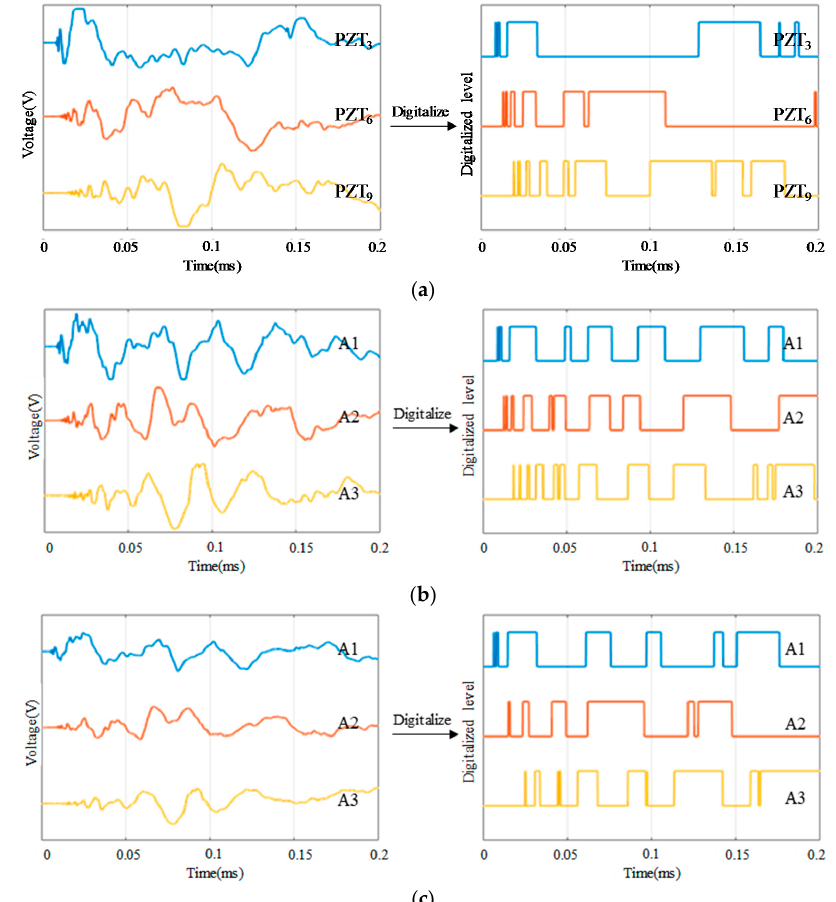
Figure 8. Typical impact response signals and CDSs of different sensor connection types under impact energy level 1: ( a ) The impact response signals and CDSs of PZT 3 , PZT 6 and PZT 9 in independent connection type; ( b ) The impact response signals and CDSs of A1, A2 and A3 in series connection type; ( c ) The impact response signals and CDSs of A1, A2 and A3 in parallel connection type.